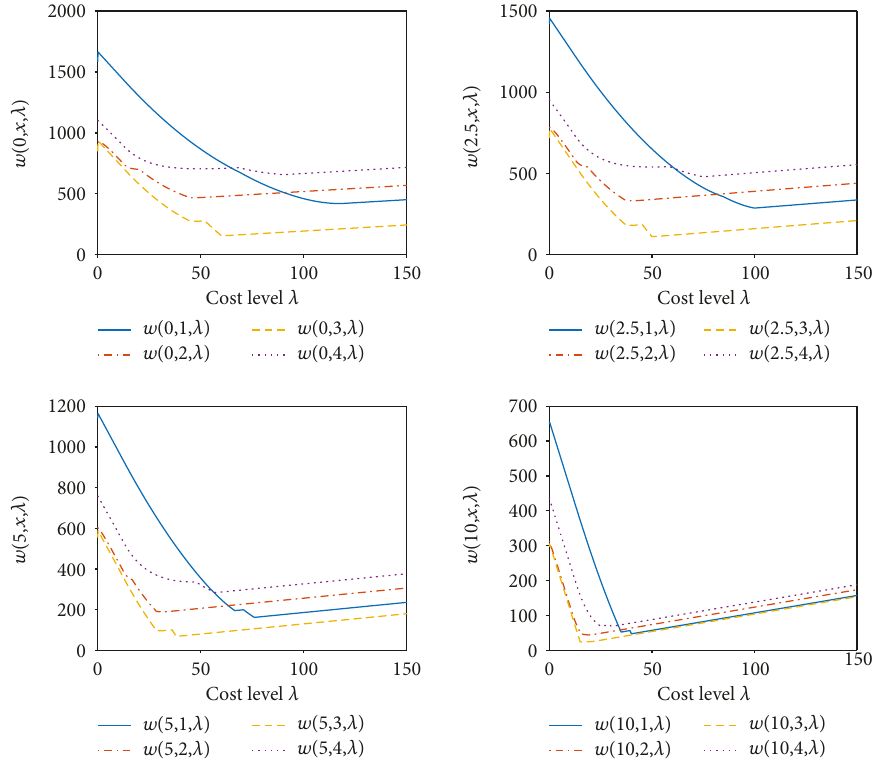
Figure 5: The function ω t , x , λ